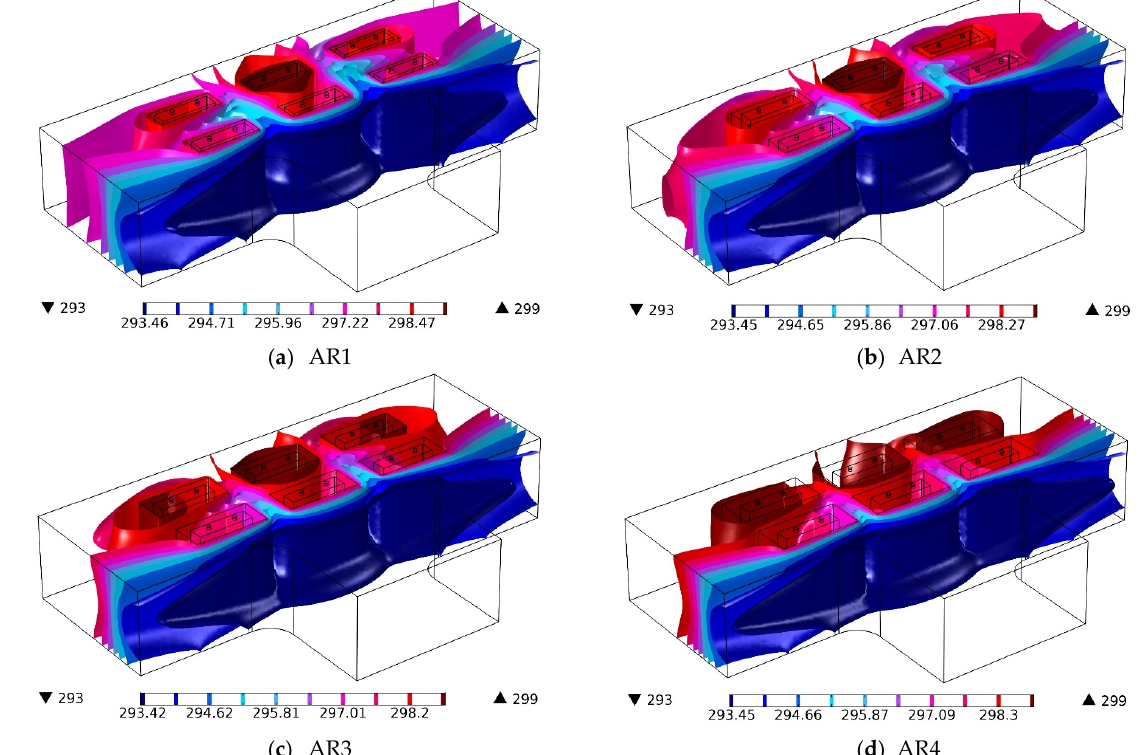
Figure 5. Isothermal planes (in Kelvin) in the airflow for different values of cavity AR.